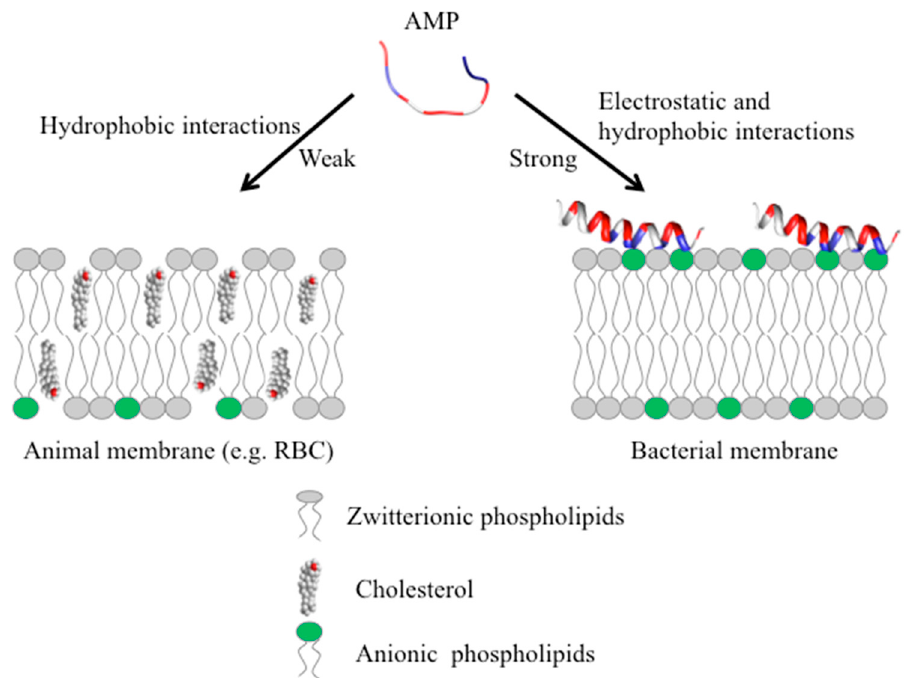
Figure 4. Initial interaction of cationic AMPs with the multicellular animal ( left ) or bacterial ( right ) membrane. RBC: red blood cell.